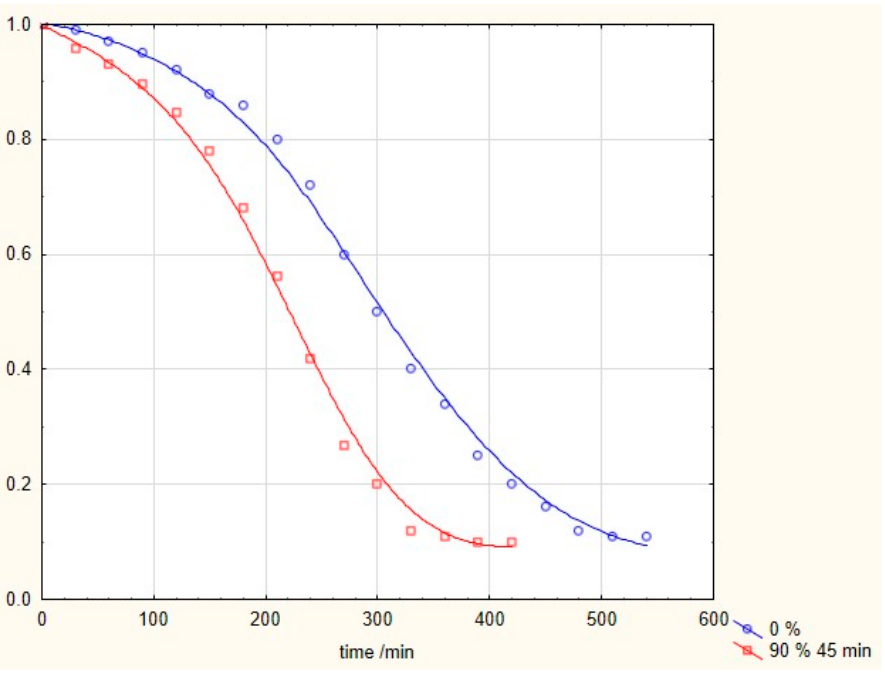
Figure 2. Relationship between the moisture ratio and drying time without US and using optimal US processing time, with Weibull model.